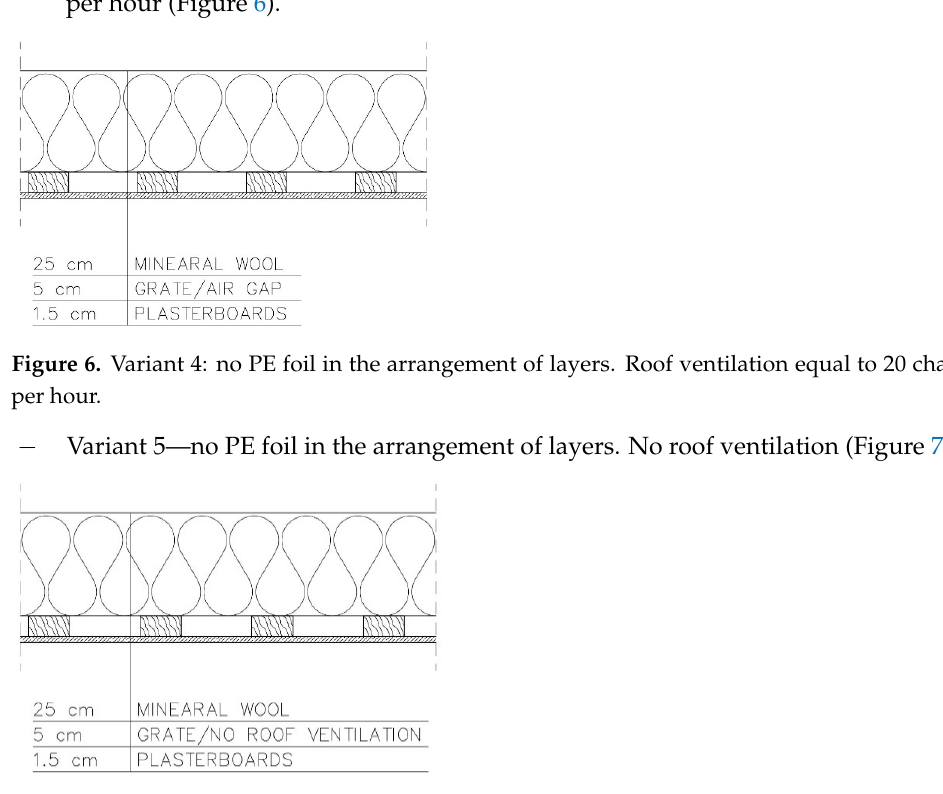
Figure 7. Variant 5: no PE foil in the arrangement of layers, no roof ventilation.